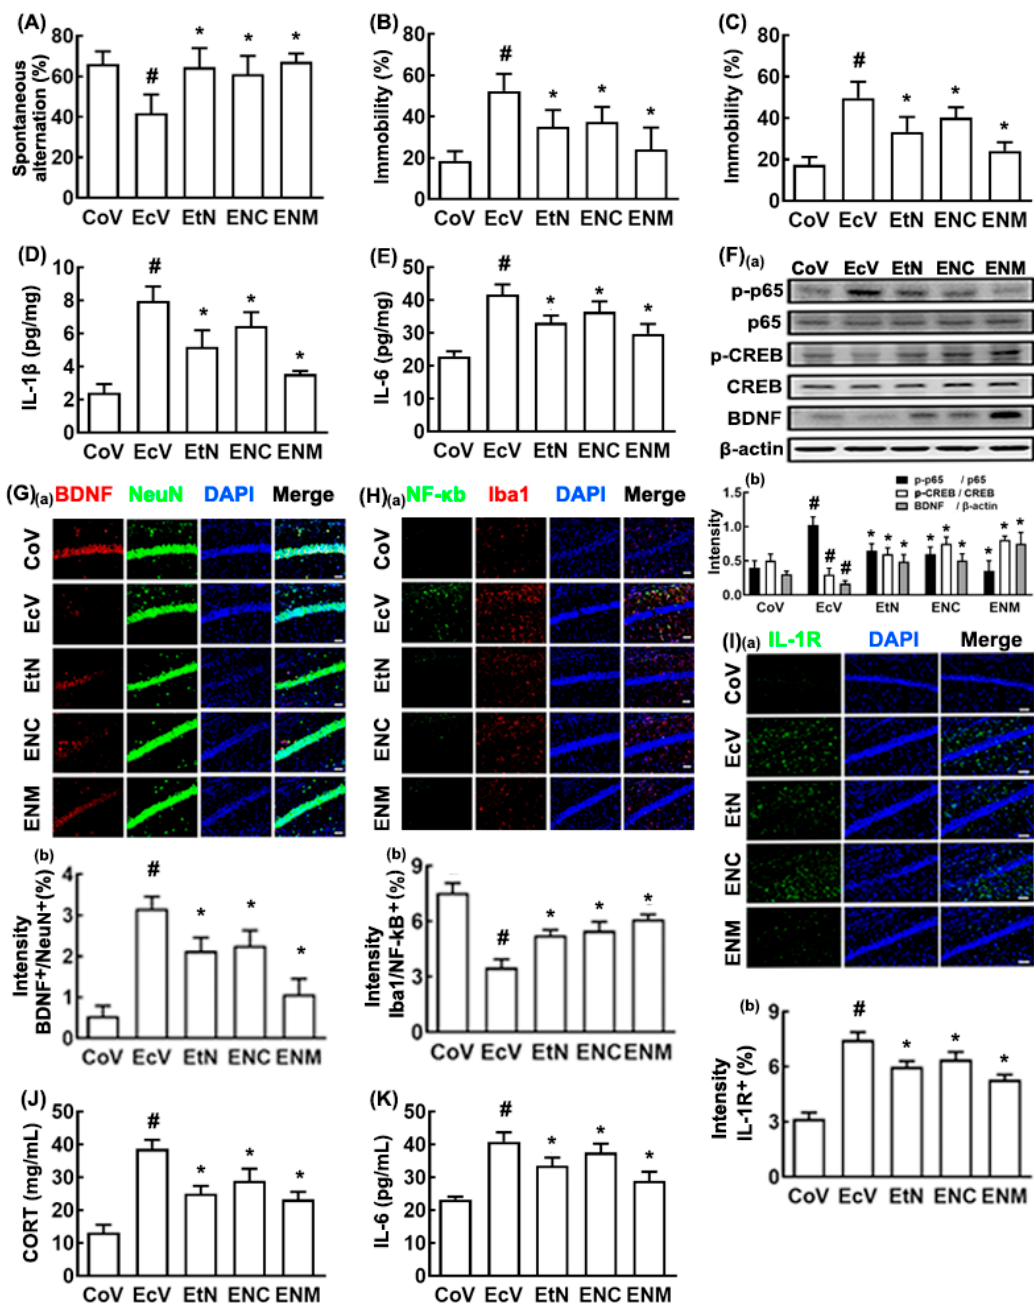
Figure 5. NK109 and its lysates NC and NM alleviated K1-induced cognitive impairment and depression in the mice. ( A ) E ff ects on the cognitive impairment in Y-maze task. E ff ects on the depressive behaviors in the TST ( B ) and FST ( C ). E ff ects on the hippocampal IL-1 β ( D ) and IL-6 levels ( E ). ( F ) E ff ects on the hippocampal BDNF expression and NF- κ B activation ( a ) and their intensities ( b ). E ff ect on the hippocampal BDNF + / NeuN + (( G ): ( a ) Confocal microscope; ( b ) their intensities), NF- κ B + / Iba1 + (( H ): ( a ) Confocal microscope photo; ( b ) their intensities), and IL-1R + cell (( I ): ( a ) Confocal microscope; ( b ) their intensities) populations. E ff ects on the blood corticosterone ( J ) and IL-6 levels ( K ), assessed by ELISA. Escherichia coli K1-treated (EcV), tyndallized NK109-treated (EtN), NK109 sonicate supernatant fraction-treated (ENC) groups were exposed to K1 and thereafter treated with test agents (EcV, vehicle; EtN, tNK109; ENC, supernatant fraction (NC) of NK109 (1 × 10 9 CFU) lysate / mouse / day; ENM, precipitate fraction (NM) of NK109 (1 × 10 9 CFU) lysate / mouse / day) daily for 5 days. Control group (CoV) was treated with saline instead of K1 and NK109. Data values were described as mean ± SD ( n = 6). # p < 0.05 vs. CoV. * p < 0.05 vs.